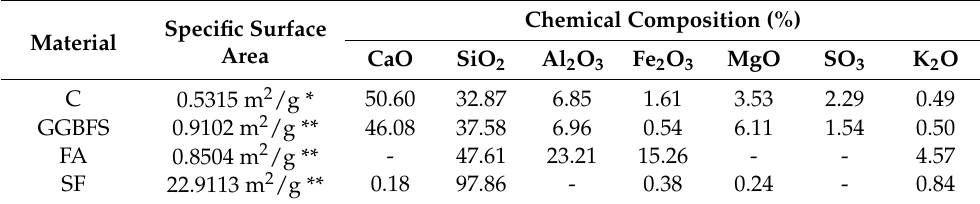
Table 2. Specific surface area and chemical composition of cementitious